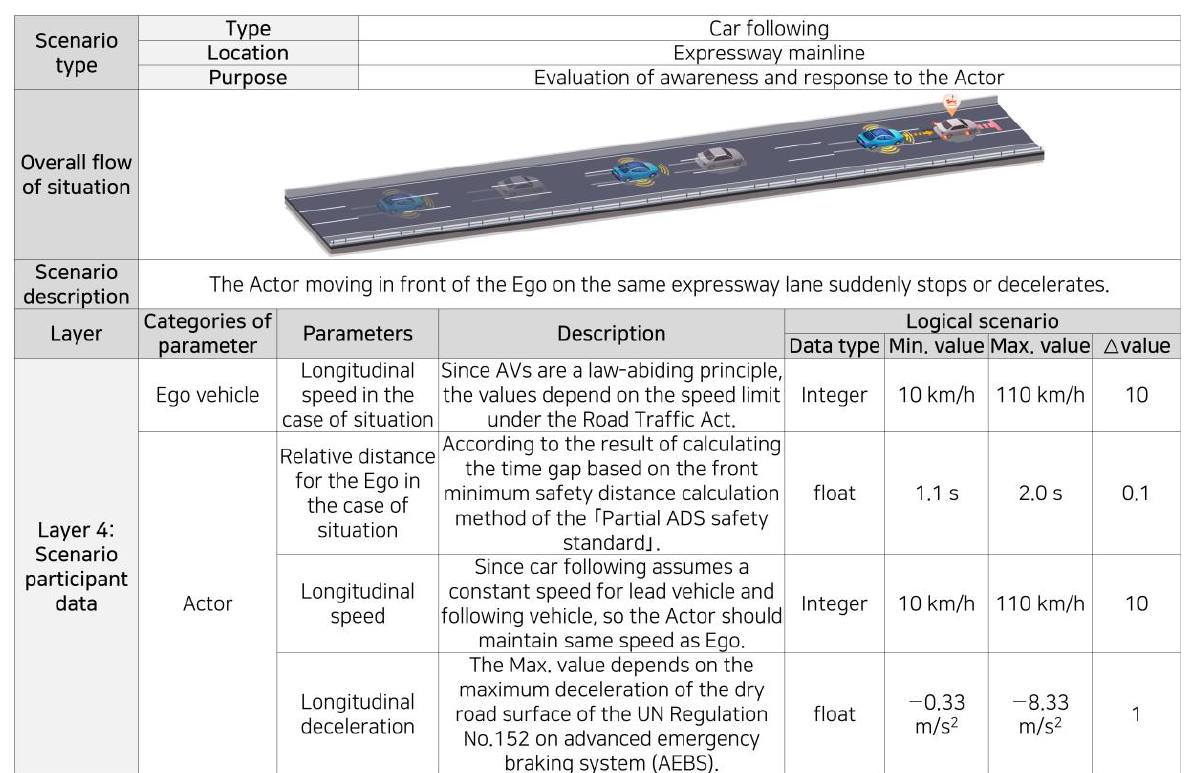
Figure 3. Logical scenario for sudden stops during a car following on the motorway main line.